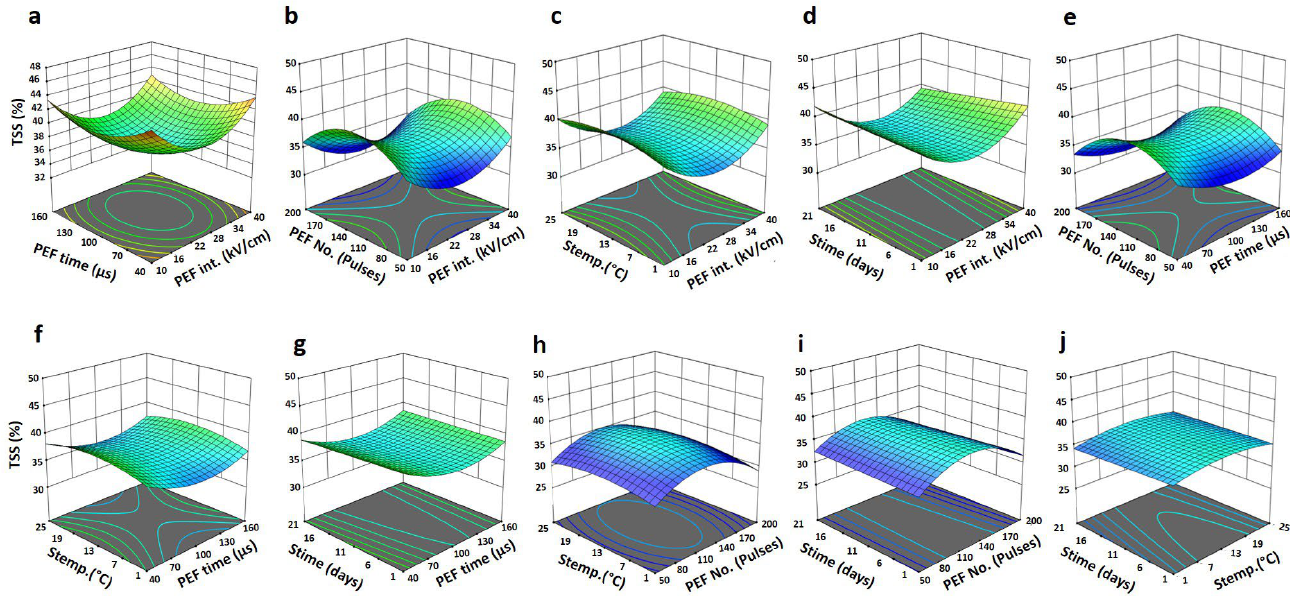
Figure 2. Response surface plots of total soluble solids (TSS) of Barhi dates as a function of PEF time and PEF intensity ( a ), PEF number of pluses and PEF intensity ( b ), storage temperature and PEF intensity ( c ), storage time and PEF intensity ( d ), PEF number of pulses and PEF time ( e ), storage temperature and PEF time ( f ), storage time and PEF time ( g ), storage temperature and PEF number of pulses ( h ), storage time and PEF number of pulses ( i ), and storage time and storage temperature ( j ).